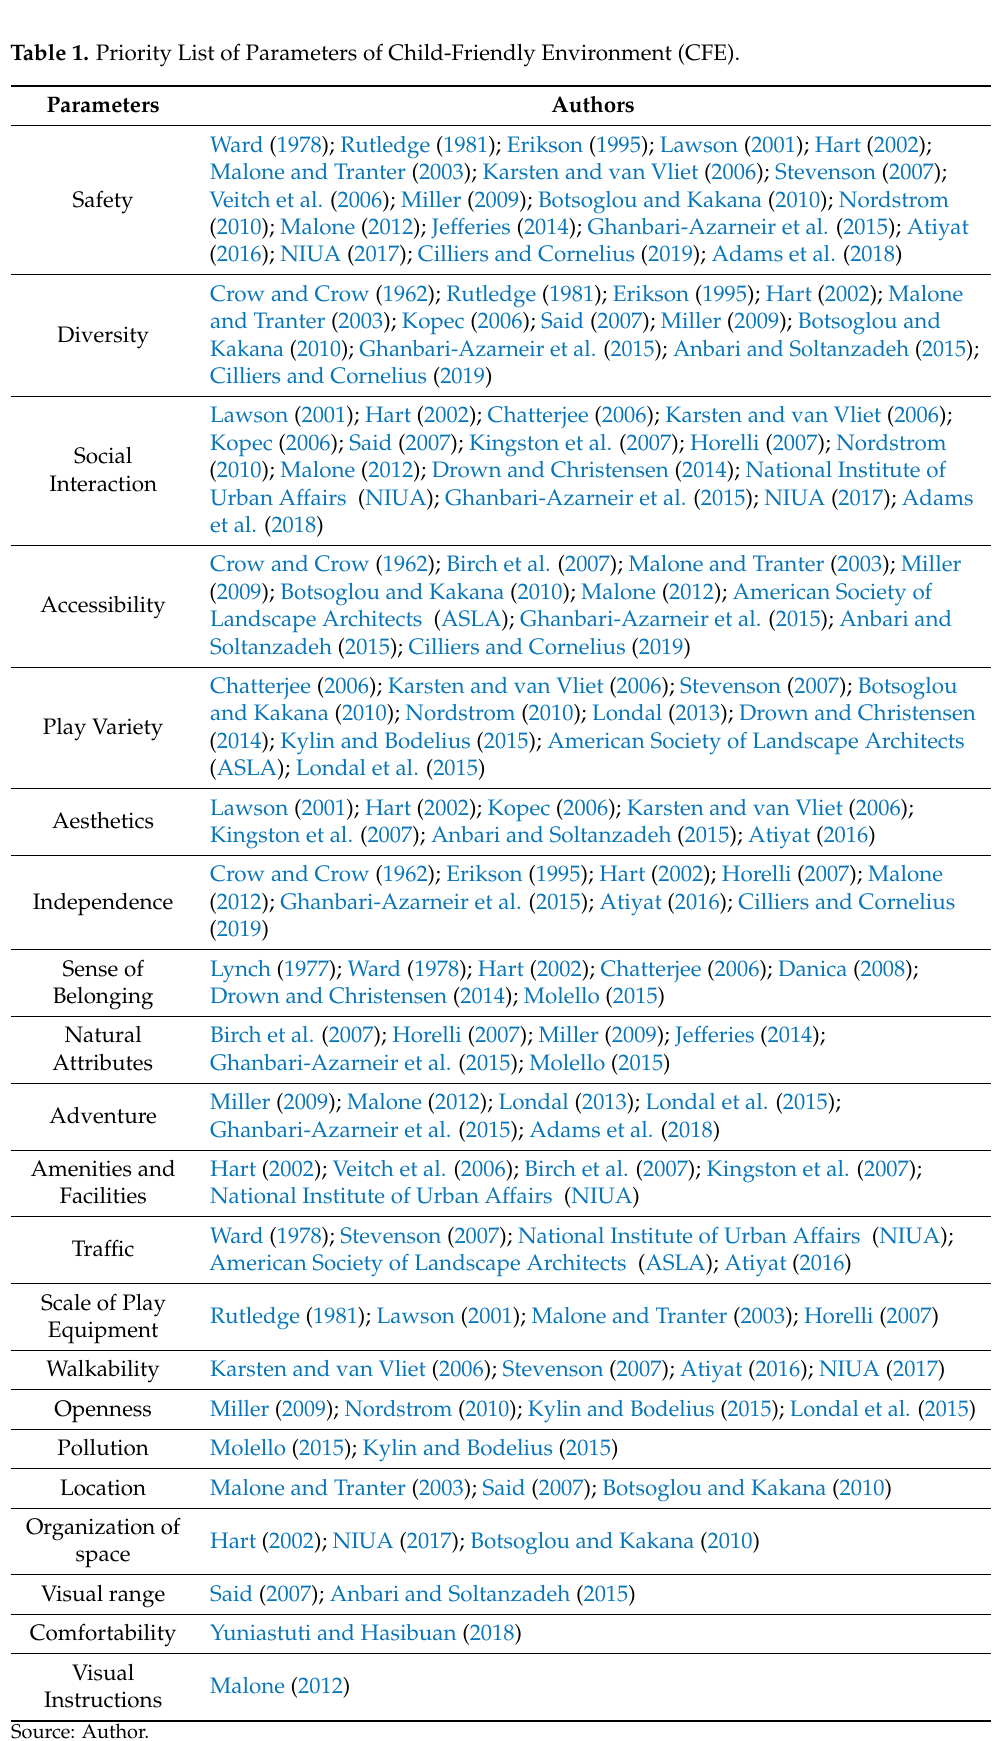
Table 1. Priority List of Parameters of Child-Friendly Environment